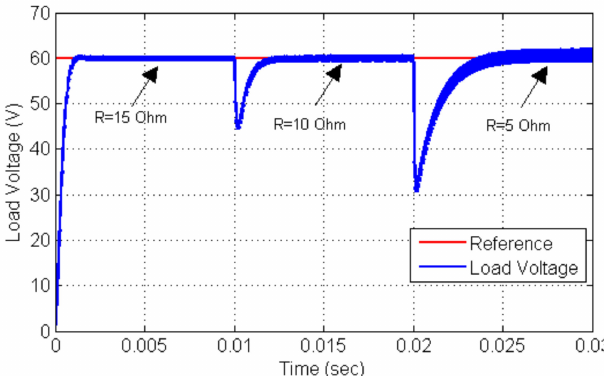
Figure 11. Output voltage response to the variation of the load resistance for desired output of 60